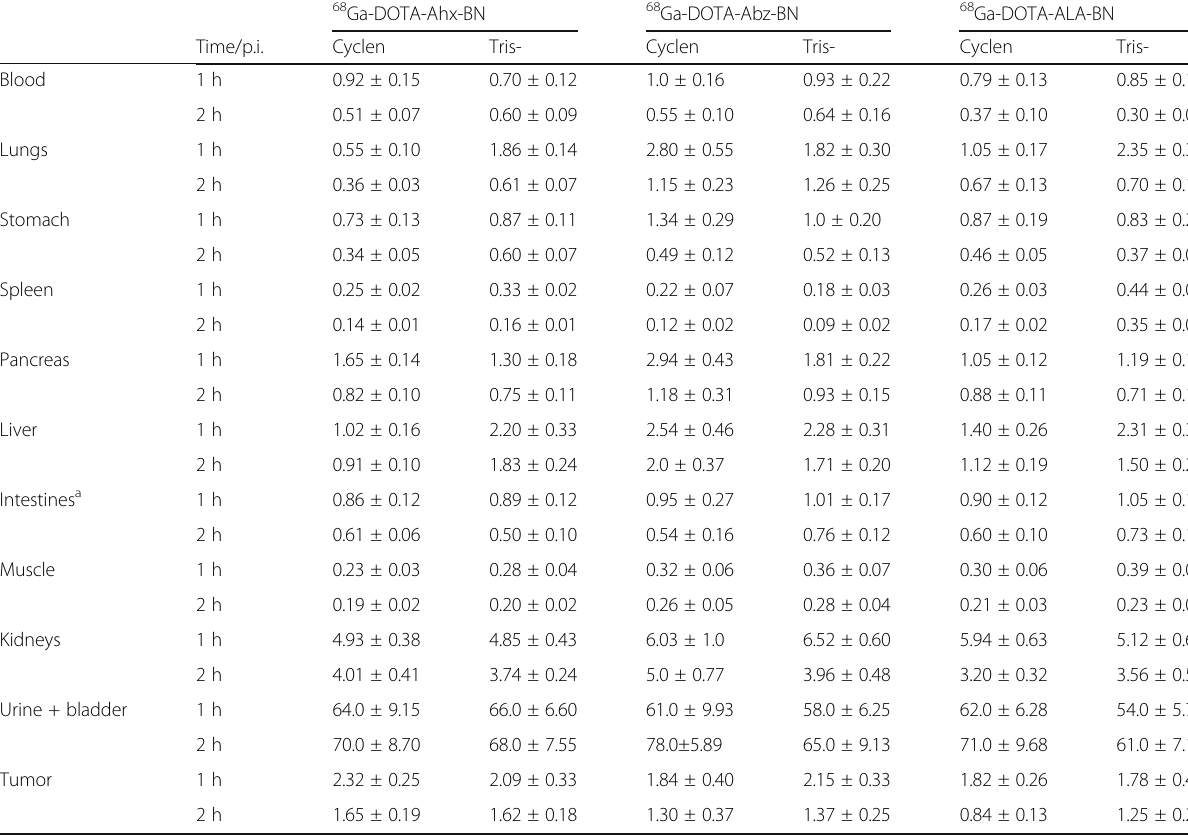
Table 4 In vivo biodistribution of 68 Ga-labeled DOTA-BN peptides in nude mice with MDA-MB-231 tumors at 1 h and 2 h post- injection ( n = 3-5). Data are expressed as % injected dose per gram of tissue (mean values ± SD). The radioactivity in the urine + bladder is expressed as % injected dose per tissue 68 Ga-DOTA-Ahx-BN 68 Ga-DOTA-Abz-BN 68 Ga-DOTA-ALA-BN Time/p.i. Cyclen